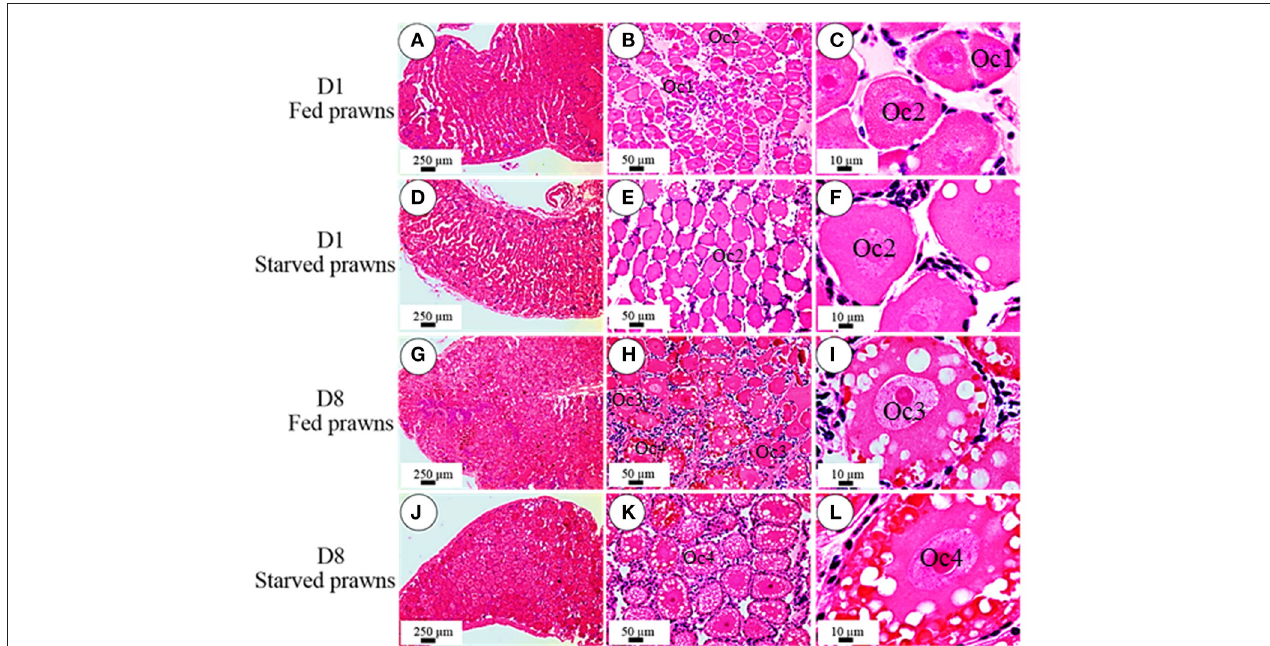
FIGURE 2 | Effect of starvation on ovarian histology and maturation of the oocytes. Light micrographs of hematoxylin and eosin- stained ovarian sections showing various stages of oocytes in the ovaries of fed prawns at day1 (A–C) , starved prawns at day1 (D–F) , fed prawns at day 8 (G–I) and starved prawn at day 8 (J–L) . Bar 250 µ m (A,D,G,J) , 50 µ m (B,E,H,K) , 10 µ m (C,F,I,L) ( n = 6).